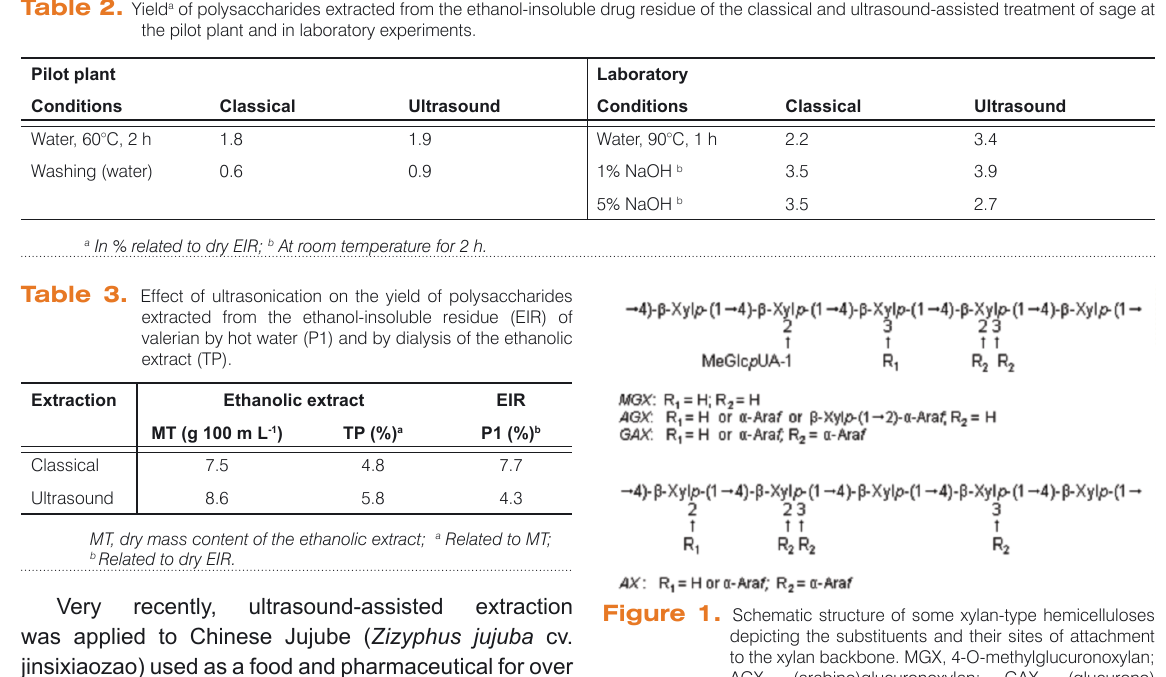
Table 2. Yield a of polysaccharides extracted from the ethanol-insoluble drug residue of the classical and ultrasound-assisted treatment of sage at the pilot plant and in laboratory experiments.